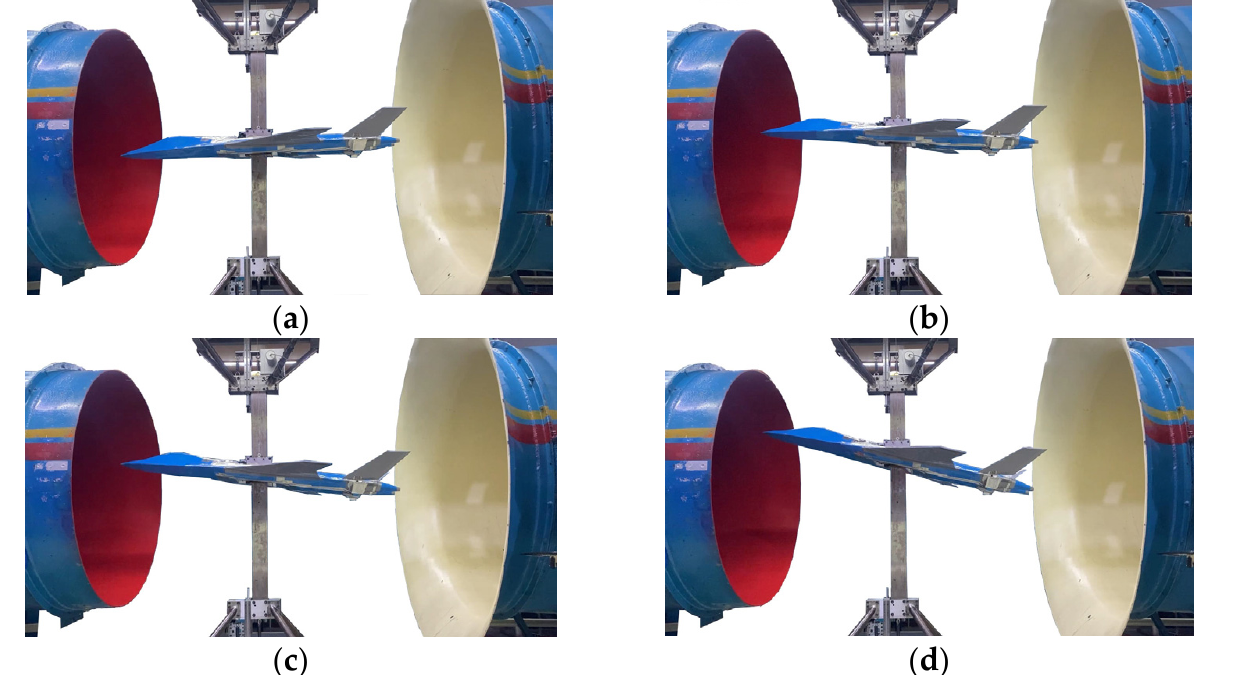
Figure 26. Captures when the model reached different target pitch angles: ( a ) − 5 °; ( b ) 0 °; ( c ) 5 °; and ( d ) 10 °.